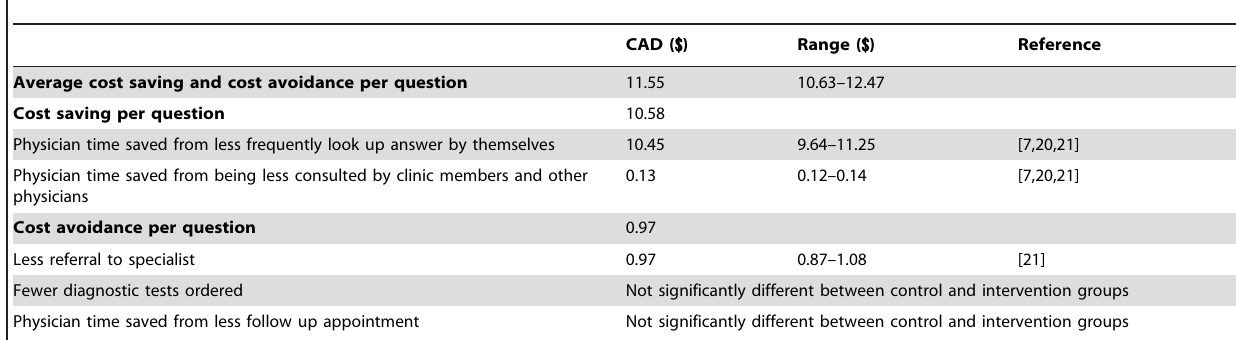
Table 2. Cost saving and cost avoidance from JIT Service (2006 Canadian